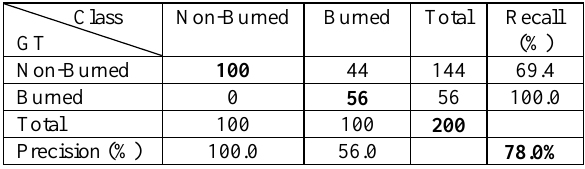
Table 4 . Confusion Matrix of ground truth (GT) and classification (Class) for the use case example in Indonesia using the global model. The bottom right cell displays the overall accuracy. The F 1 -score for non-burned is 81.9% and for burned 71.8%.